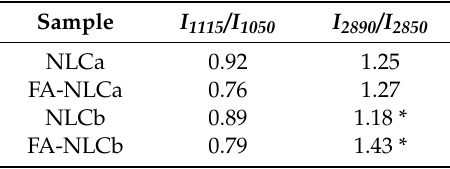
Table 3. Raman intensity ratios related to C-C stretching vibrational bands, I 1115 /I 1050 , and Intensity Raman ratios, I 2890 /I 2850 , for the C–H stretching vibrational bands of unloaded and FA-loaded NLC. Values are the mean of the intensity of 100 accumulation spectra acquired from five different regions with a spatial resolution of 5 microns in each sample. SD is <0.02 for all averages. * Significance for p < 0.05. Sample